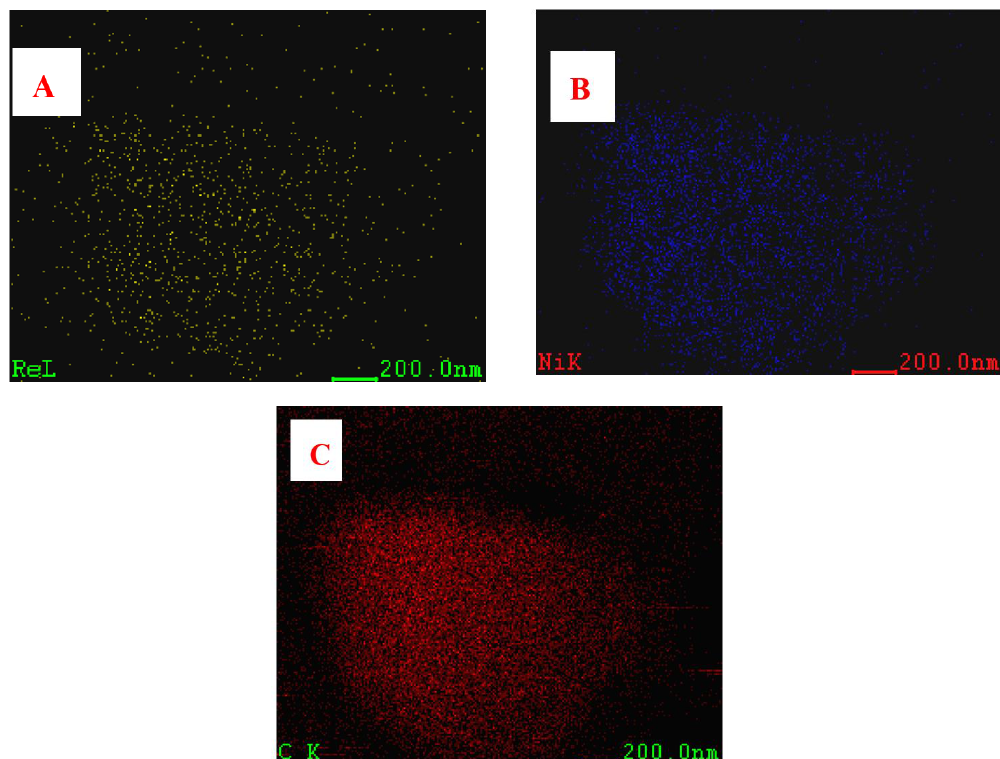
Figure 3. The elemental mapping of 5% Ni-Re/AC (n Ni: n Re = 1:1) catalyst: ( A ) Re; ( B ) Ni; and ( C ) C.